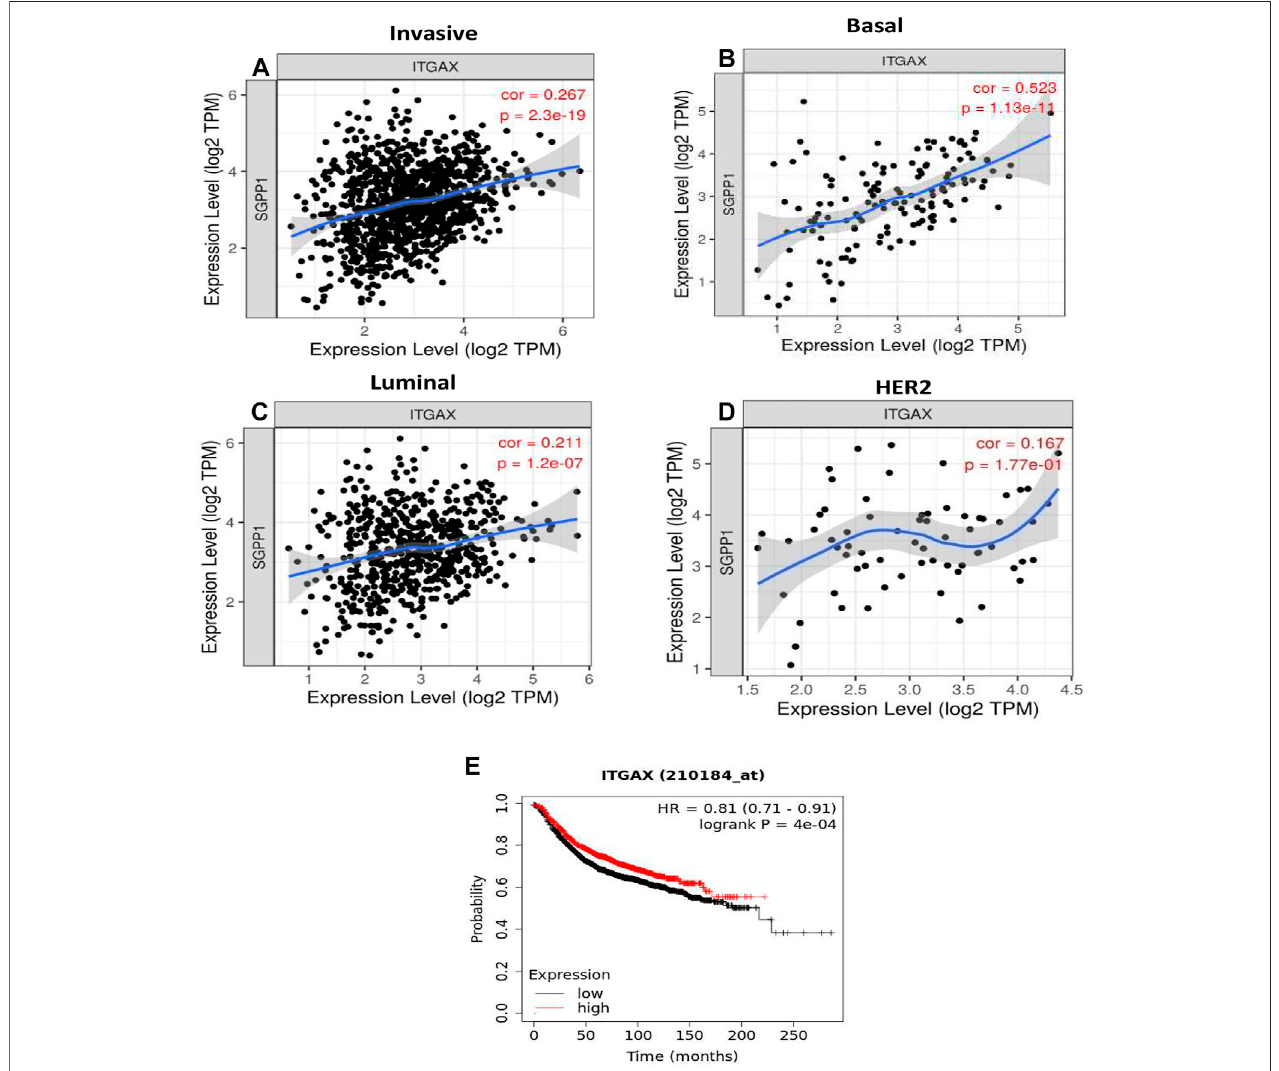
FIGURE 5 | The SGPP1 gene with invasive breast carcinoma, basal, luminal and HER2+ and SGPP1 is signi fi cantly associated with basal-like tumor-in fi ltrating immune cells according to correlation via TIMER. (A – D) , SGPP1 (where A (cid:2) invasive breast carcinoma, B (cid:2) basal-like breast carcinoma, C (cid:2) luminal breast carcinoma, and D (cid:2) HER2+ breast carcinoma). High expression of integrin subunit alpha X ( ITGAX ) is signi fi cantly associated with relapse-free survival (RFS) of breast cancer patients. (E), Kaplan-Meier survival curves (RFS) were plotted for ITGAX for breast cancer.